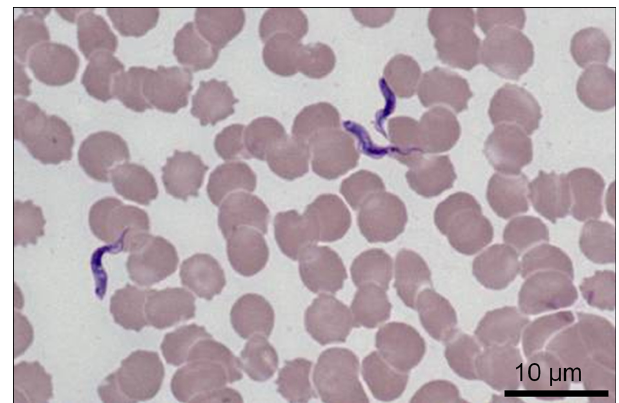
Figure 2. Cytological examination of blood smears showed numerous free parasites (May-Grünwald-Giemsa